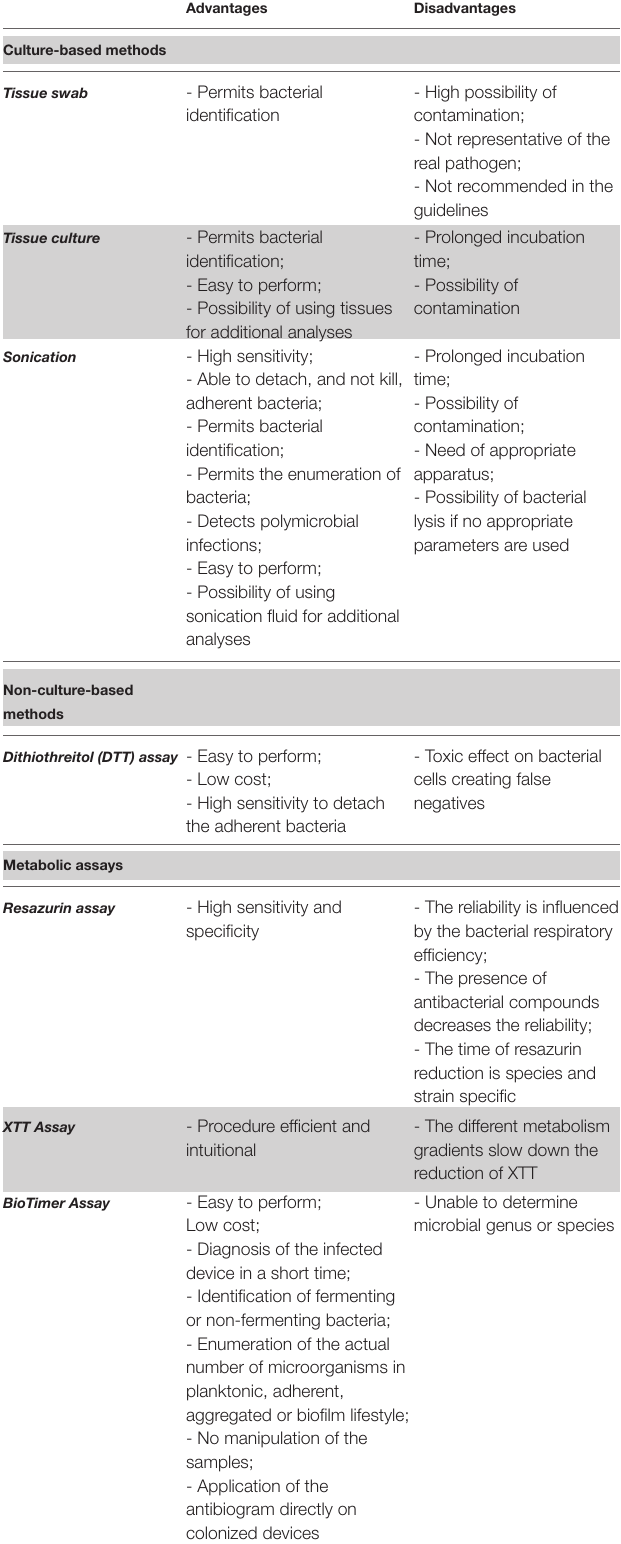
TABLE 1 | Overview of the principal advantages and disadvantages of culture- and non-culture based methods for the diagnosis of implant-associated infections.